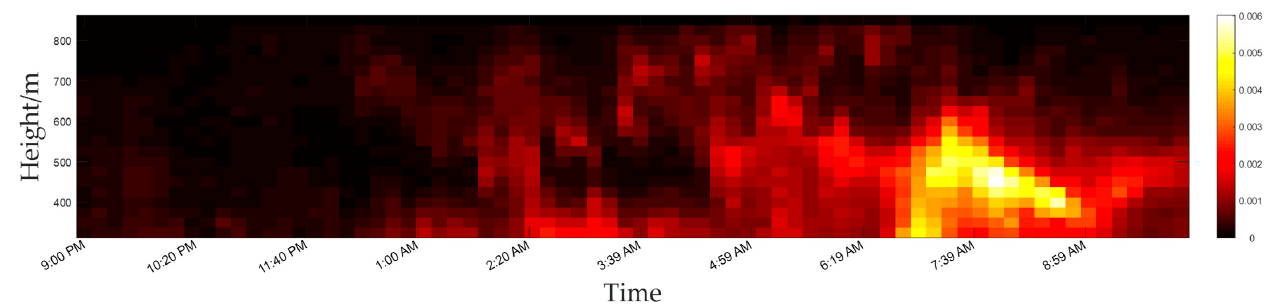
Figure 13. Migration flux with the height interval h Δ = 25 m and time interval T Δ = 600 s.